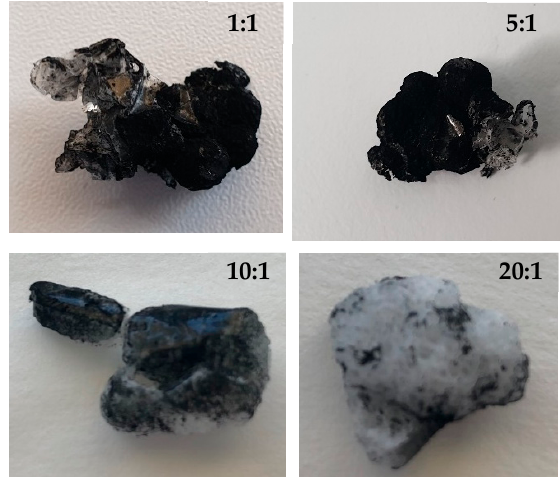
Figure 2. Images of the scaffolds formed in runs 1 to 4.